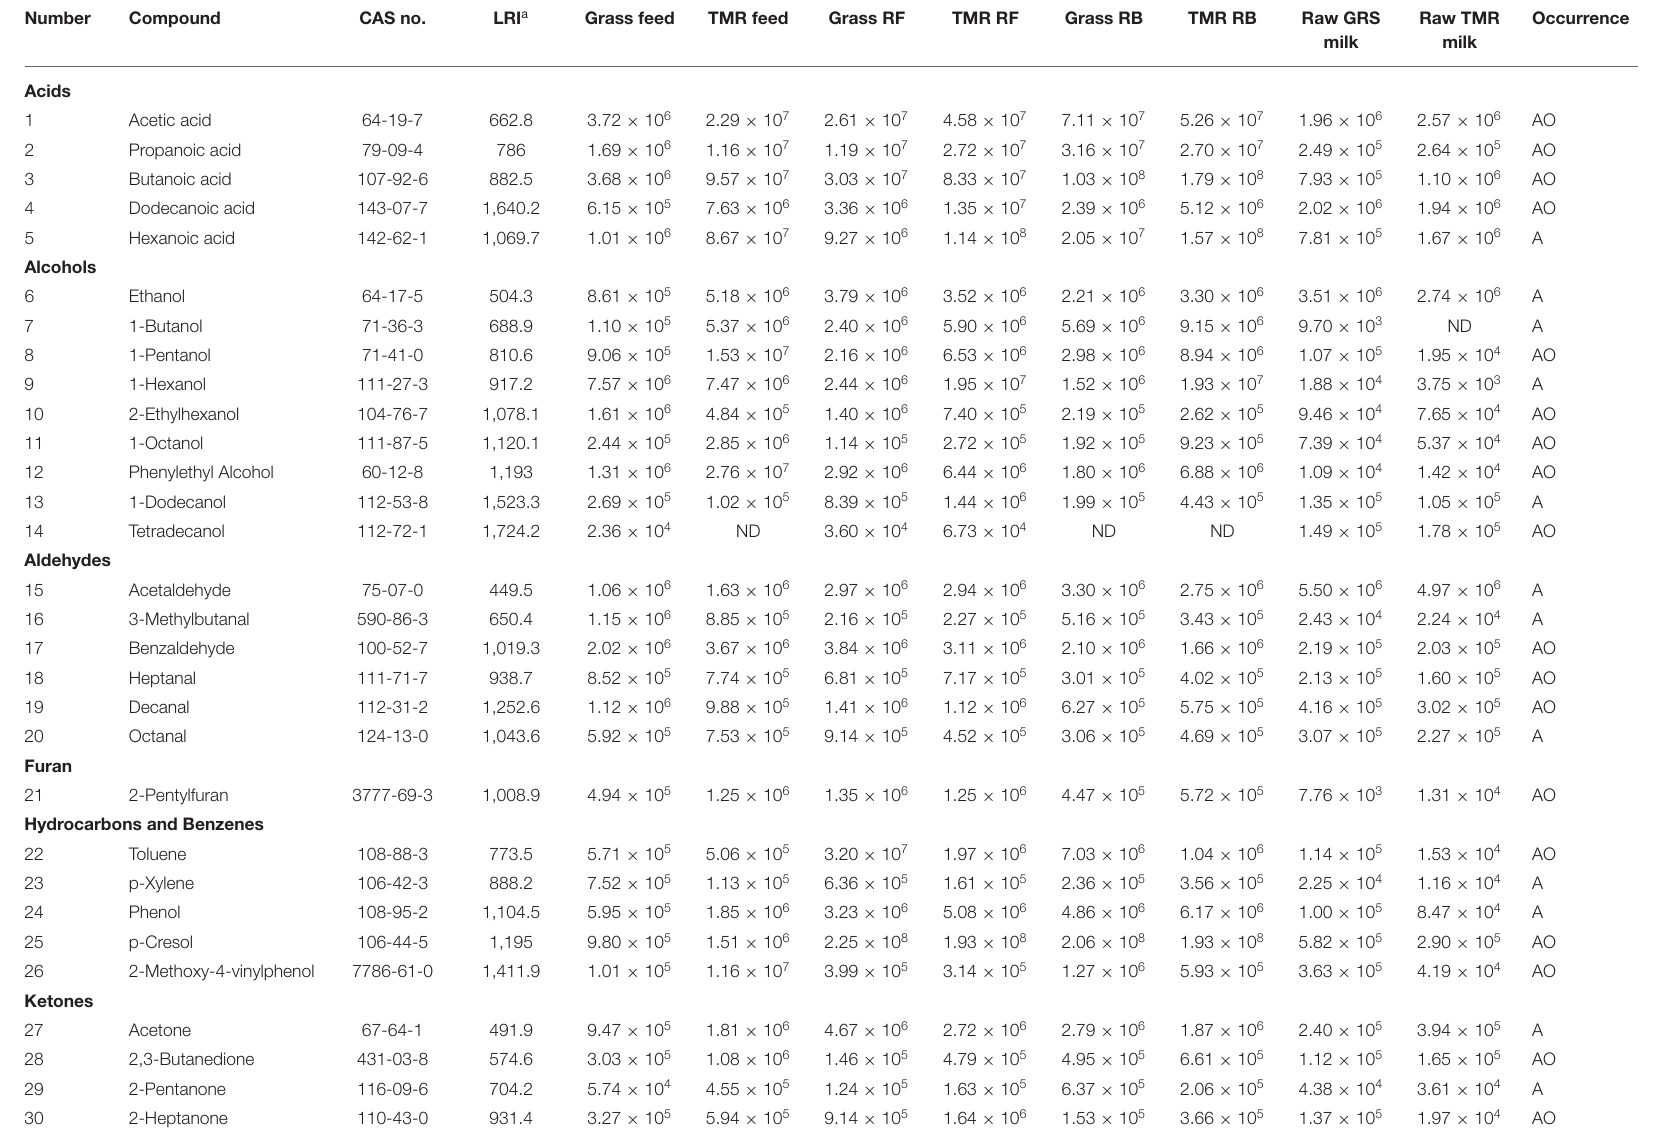
TABLE 2 | Volatile organic compounds present in all samples [feed (grass (GRS) and TMR, rumen fluid (RF), rumen blended (RB), raw grass (GRS), and TMR